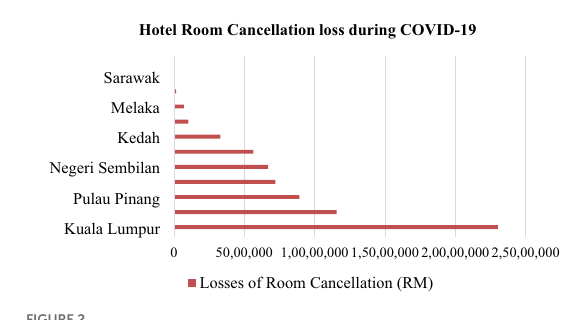
FIGURE 2 Hotel room cancellations loss. Malaysian Association of Hotels [MAH] (2020) (Ministry of Finance, 2020).